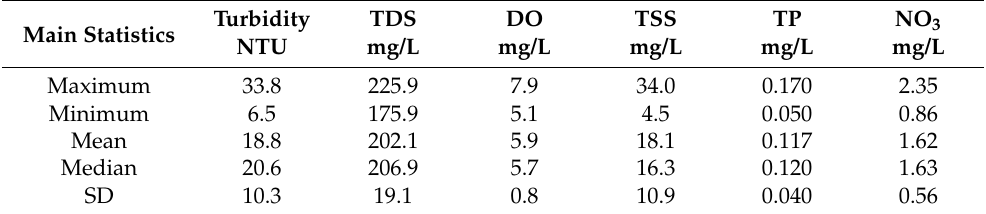
Table 2. Main statistics (mean, range, and standard deviation) for the following water quality parameters: nitrate (NO 3 ), total phosphorus (TP), total suspended solids (TSS), turbidity, total dissolved solids (TDS), and dissolved oxygen (DO) measured during the field